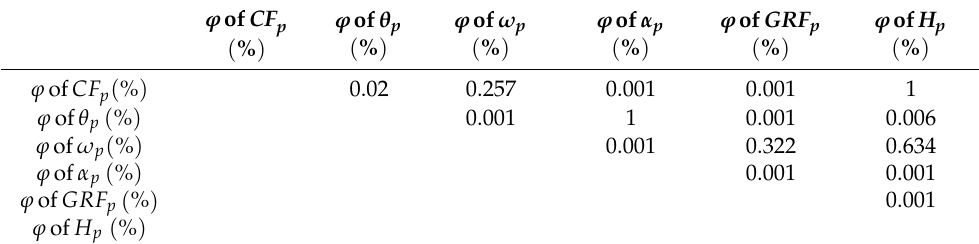
Table 3. The p -values of multiple comparisons (Kruskal-Wallis test and Dunn-Bonferroni correction) of ϕ for each parameter. The Kruskal-Wallis test shows p = 0.06, which rejects the hypothesis that ϕ of each parameter is the